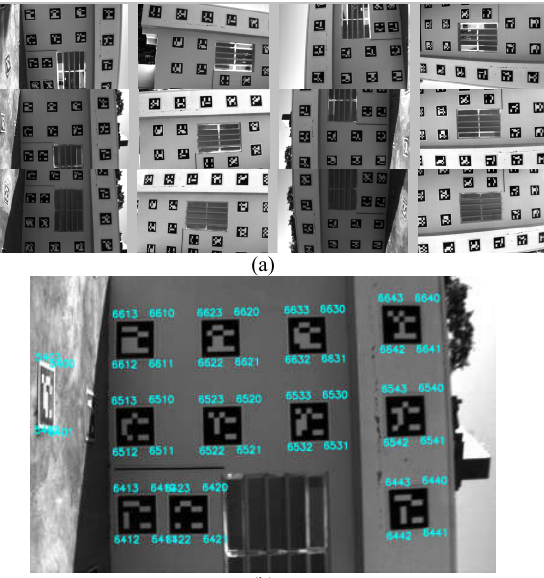
(b) Figure 3. (a) Set of twelve images of band 8 (605.64 nm) used for calibration; (b) example of corners automatically extracted and labelled.